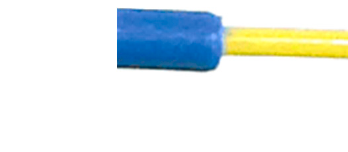
Figure 11. Layered cable with steel strengthening insert: ( a ) before the deformation; ( b ) after the permanent (plastic) deformation.